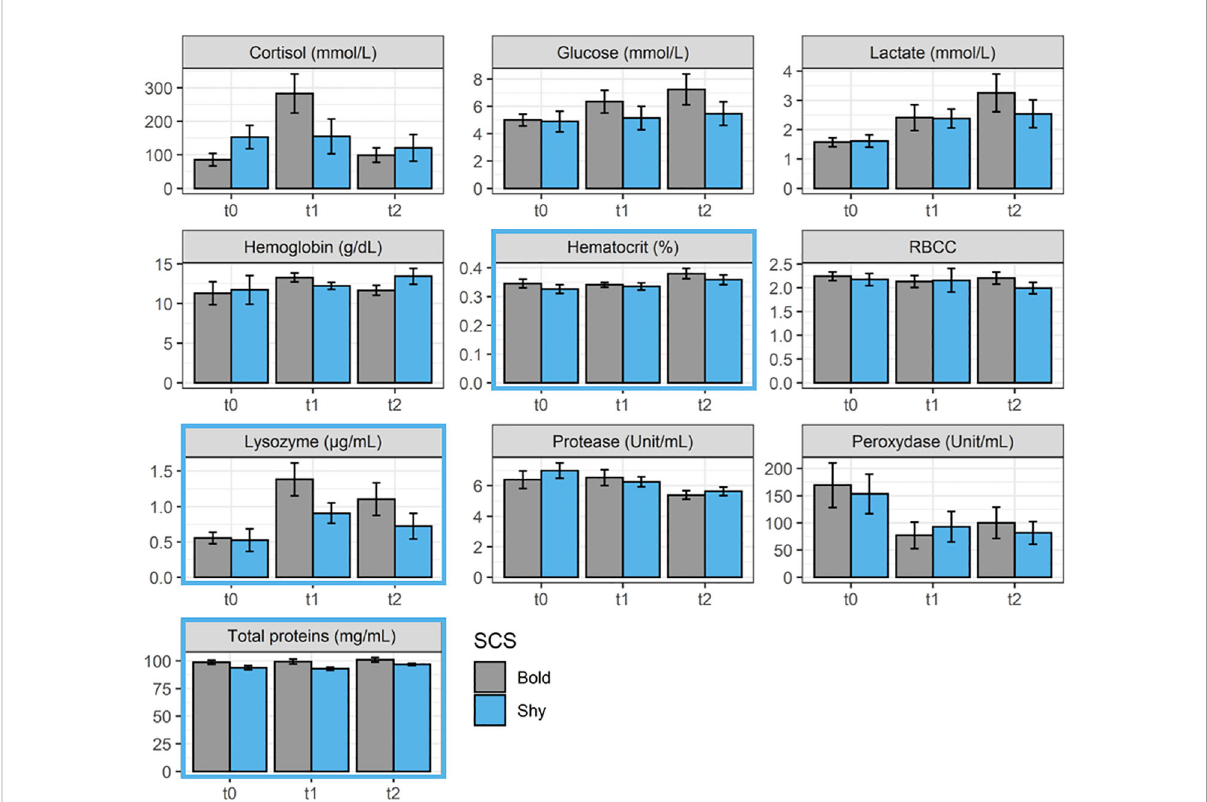
FIGURE 3 Physiological blood parameter [cortisol, glucose, lactate, hemoglobin, hematocrit, red blood cell count (RBCC), lysozyme, protease, peroxidase, and total proteins] concentrations during the experiment recorded in bold (gray, n = 9 per sampling time) and shy fi sh (blue, n = 9 per sampling time) at t 0 , t 1 , and t 2 . A blue outline around the fi gures indicates a signi fi cant effect of SCS in the parameter (see statistical details in the